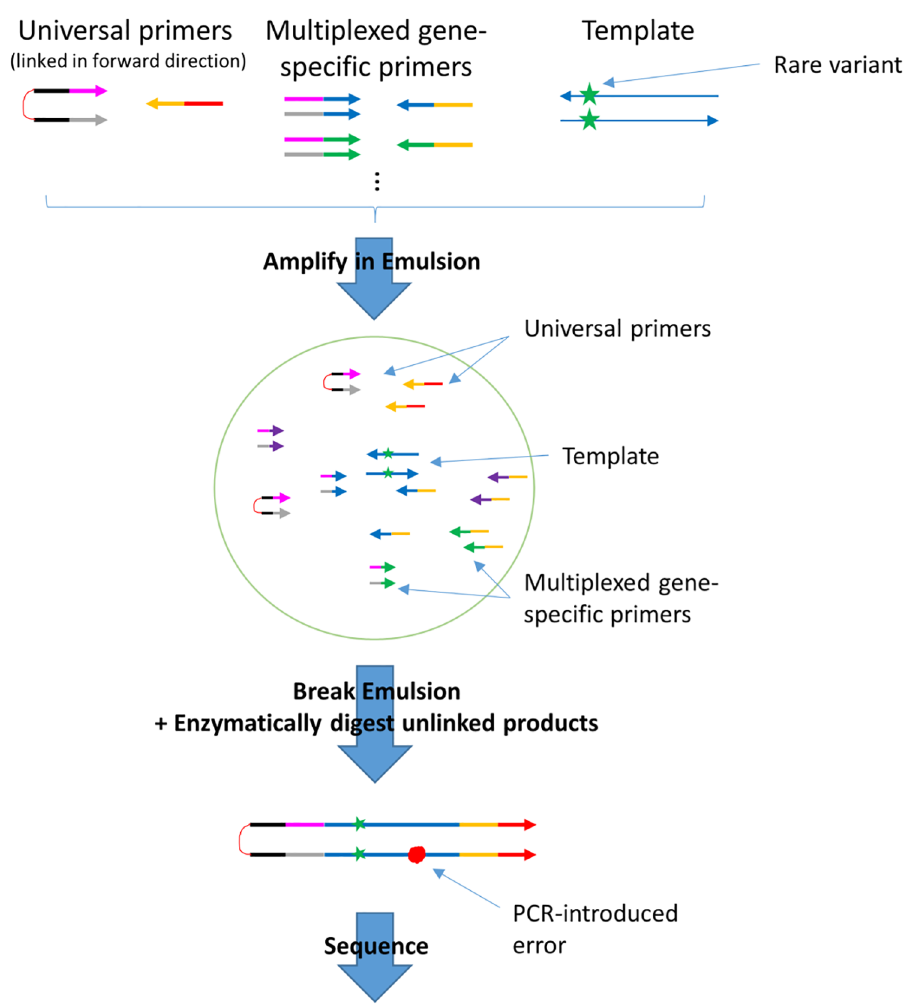
Fig 4. Overview of the targeted Pro-Seq workflow (described in detail in the Materials and methods). In brief, double stranded DNA is loaded directly into droplets such that on average zero or one template molecule is incorporated in each droplet. Off-target DNA (not shown in figure) is also loaded into droplets, but does not amplify. Within each droplet are multiplexed gene-specific primers, and the Pro-Seq universal 5’ PEG-linked primers. The droplets are PCR cycled such that all copies of the starting template are linked to the universal linked primers (shown in detail in S2 Fig). The emulsions are then broken, and the un-linked strands are digested and cleaned up. After quantification, the library is ready for